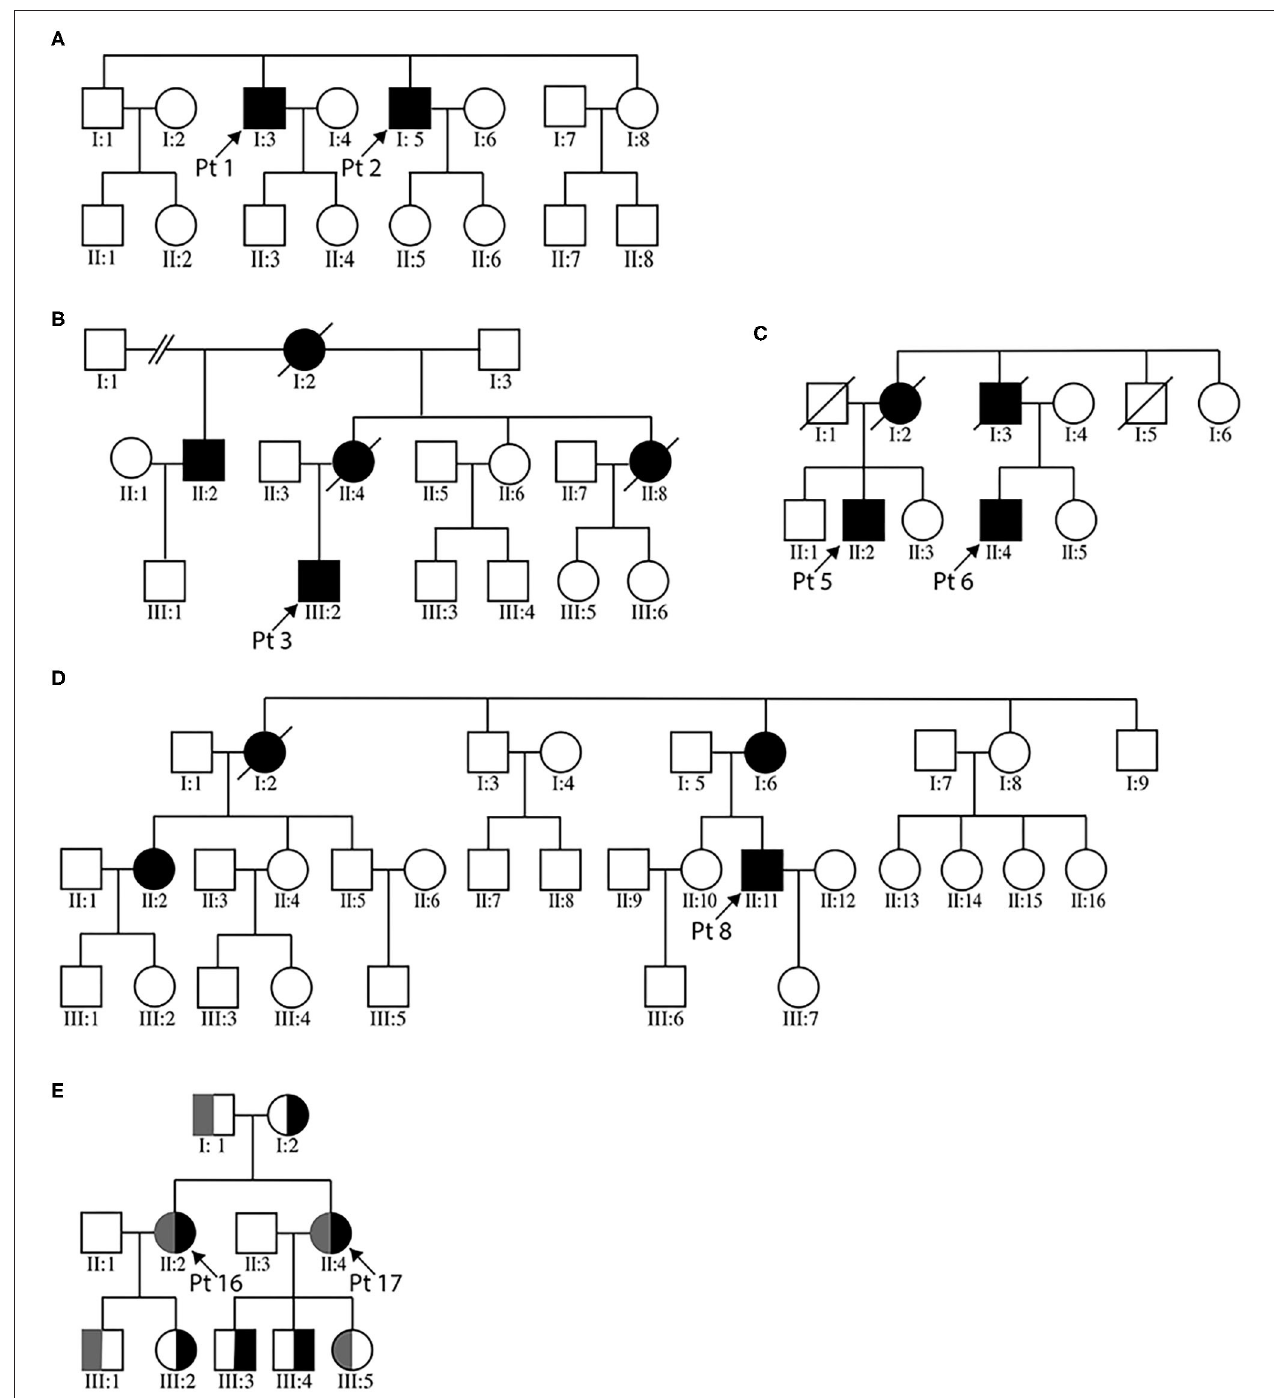
FIGURE 1 | Pedigree charts of the enrolled MFM patients. (A–D) illustrate the three desminopathy families. (E) demonstrates the family tree of patients 16 and 17. For panel (E) , gray bar represents the c. 107545delG mutation carrier, black bar the c. 19993G > T carrier.